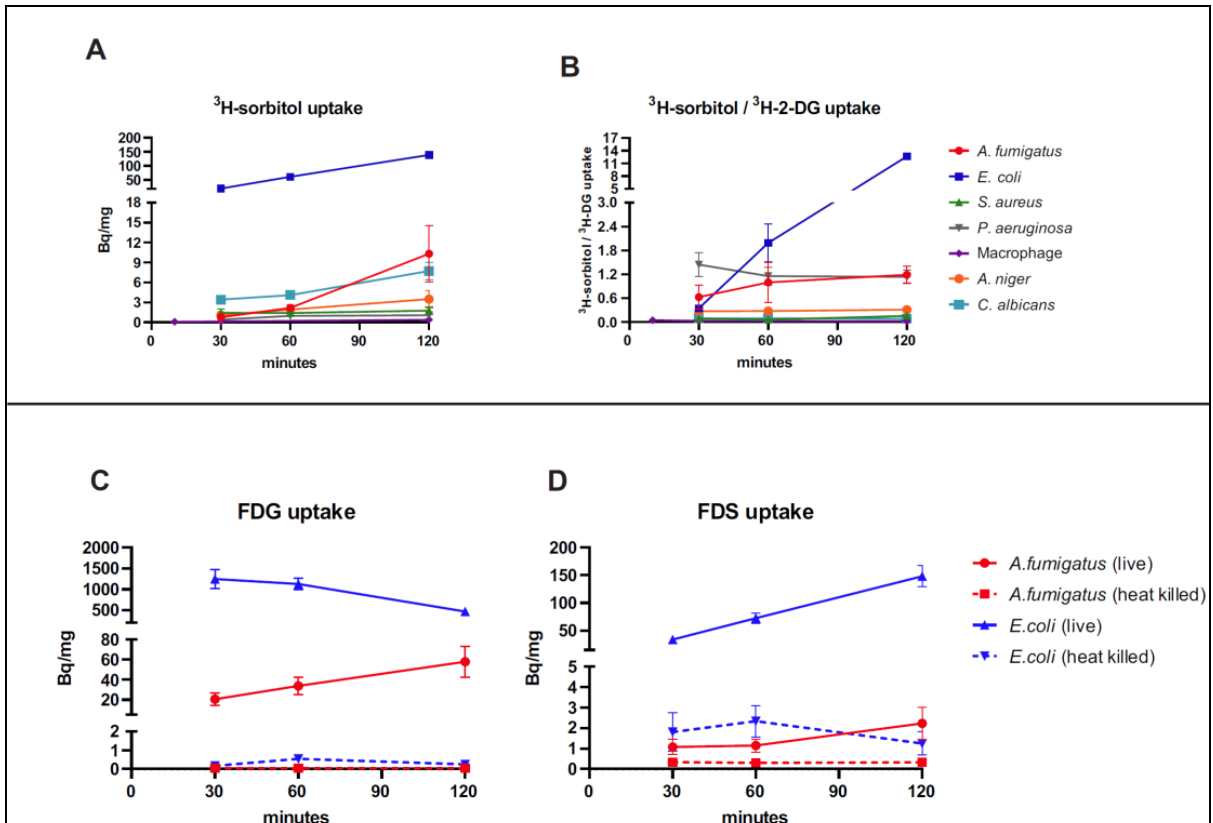
Figure 1. In vitro uptake assays. ( A ) 3 H-sorbitol uptake and ( B ) ratio of 3 H-sorbitol uptake to 3 H-2- Deoxyglucose (DG) uptake in A. fumigatus , E. coli , S. aureus , P. aeruginosa , A. niger , C. albicans , and J774A macrophages. ( C ) 2-[ 18 F]-fluorodeoxysorbitol (FDS) uptake and ( D ) 18 F-fluorodeoxyglucose (FDG) uptake in live and heat-killed E. coli and A. fumigatus cultures, incubated for 120 min. Heat- killed A. fumigatus or E. coli were used as negative controls. Data are expressed as means ± SEM of 3 or more replicate experiments.